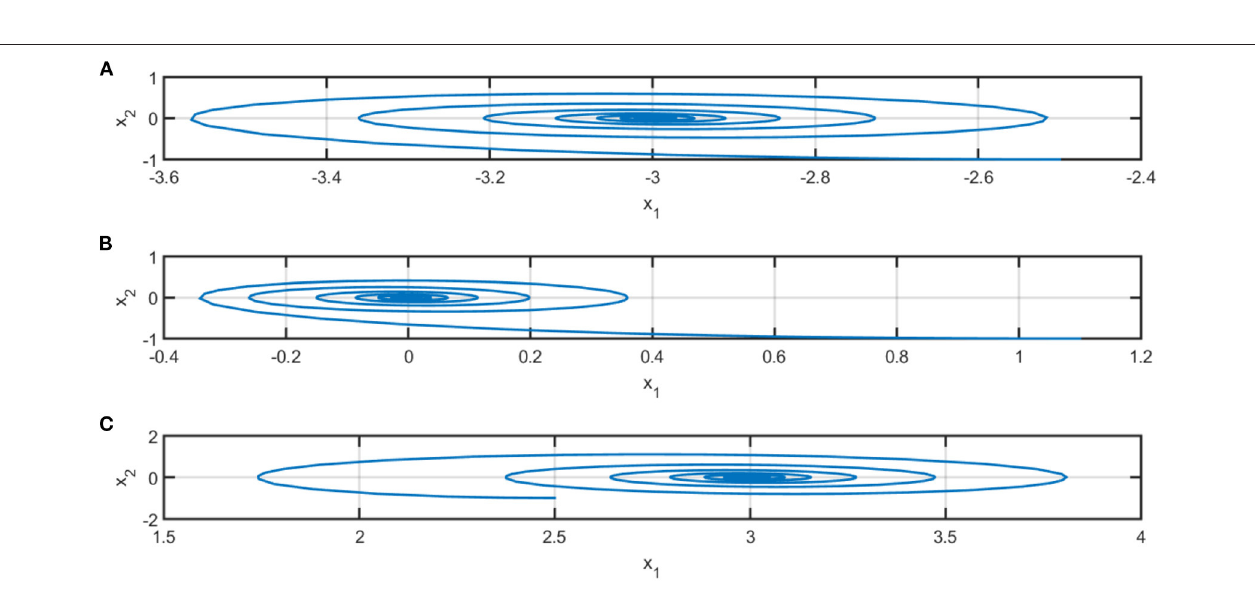
, implication ( I 2 implies I 1 ); I ′ of I 2 ; I 1 + I ′ 2 + I 2 , implication ( I 1 implies I 2 ); ( I 1 I 2 ) ′ , NAND; ⊤ , tautology I ′ 1 or